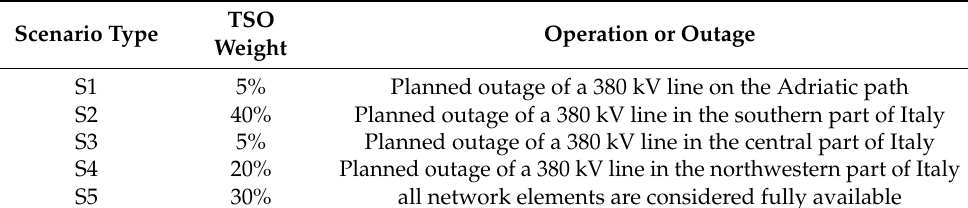
Table 1. Types of scenarios [9].